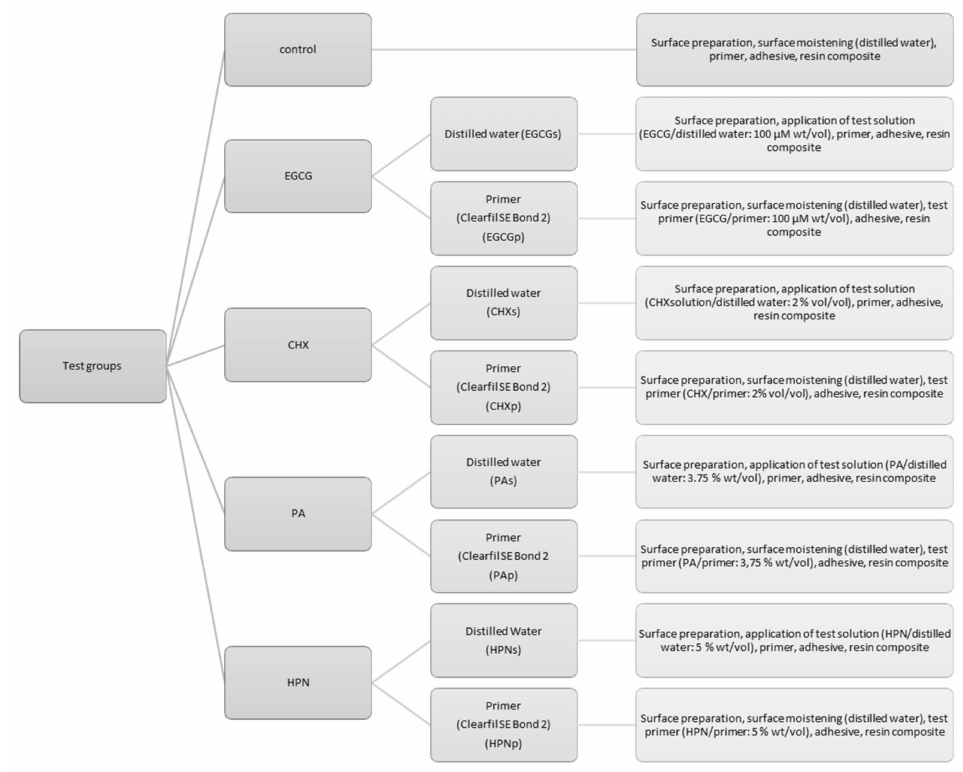
Figure 2. Description of the test groups; each tested after one week, one month, three months, six months, and one